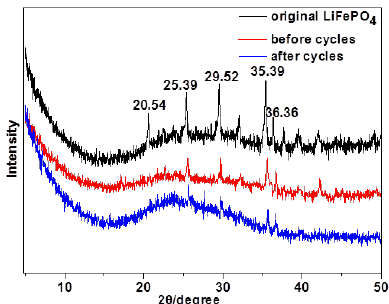
Figure 11. XRD patterns of LiFePO 4 electrode powder of original, before and after 50 cycles.